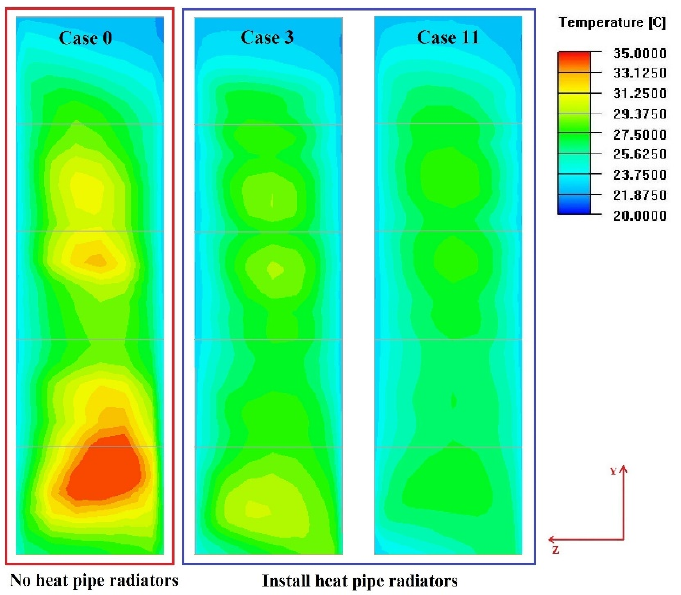
Figure 16. The comparison of heat distribution profiles of the air outlet of the rack B4 under three different conditions.